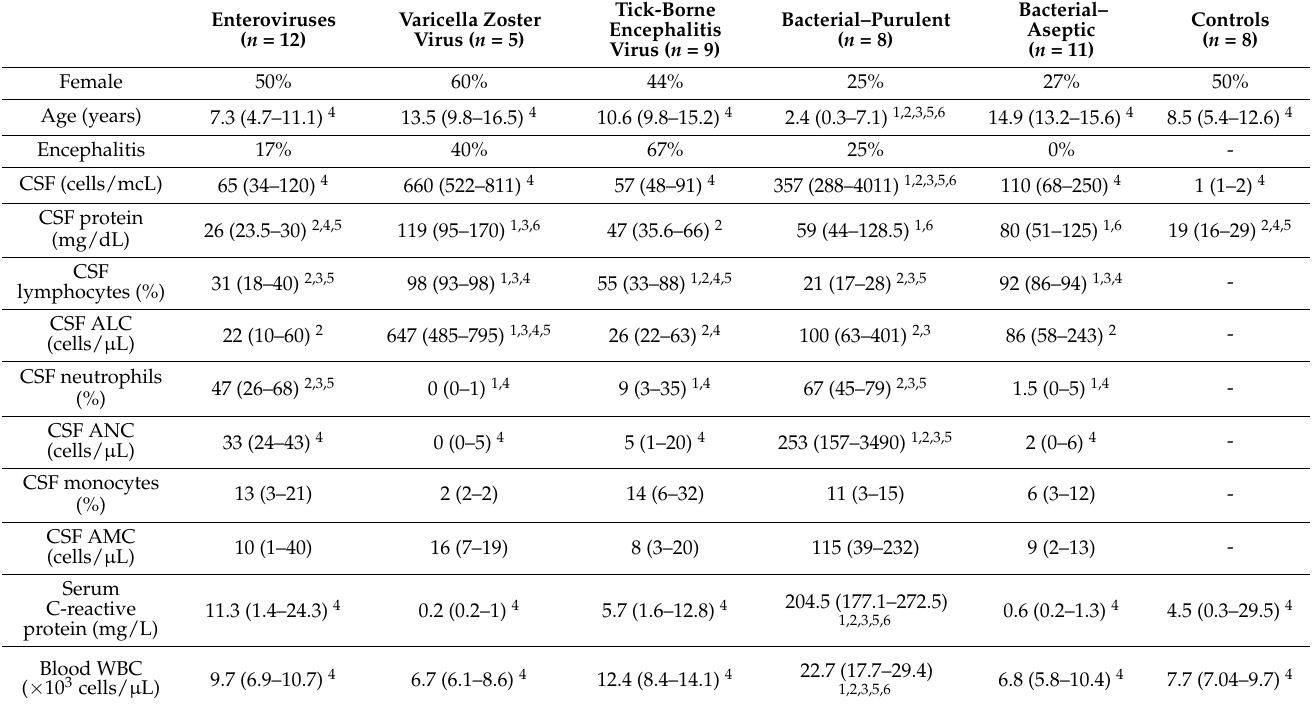
Table 1. Clinical characteristics of the study